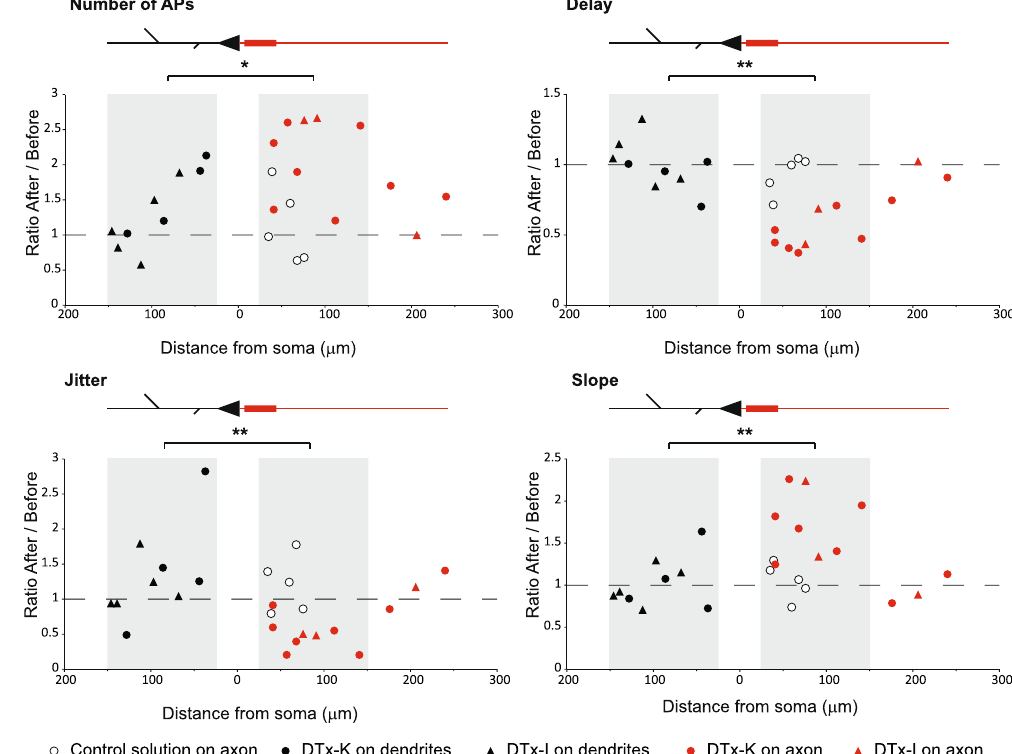
Figure 3. Effect of puffing DTx-K or DTx-I on global excitability according to the distance from the soma. Full set of experiments, showing the relative effect of DTx-K or DTx-I on the delay, number of APs, jitter and slope and according to the distance from soma, on axon or dendrites of CA3 pyramidal cells. White circles: puff of control extracellular solution on the axon; black circles: puff of DTx-K on dendrites; red circles: puff of DTx-K on axon; black triangles: puff of DTx-I on dendrite; red triangles: puff of DTx-I on axon. Note the maximum effect of DTx on the excitability around 50 µ m on the axon, which coincides with AIS position. Grey